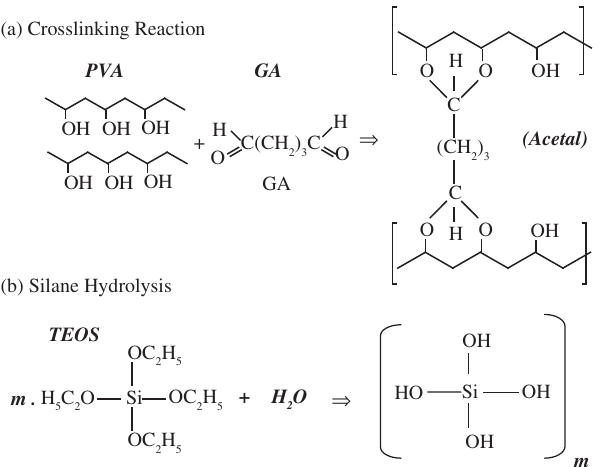
Figure 2. Chemical structure of reagents and schematic representation of reactions involved; a) PVA and glutaraldehyde crosslinking; and b) TEOS alcoxide hydrolysis